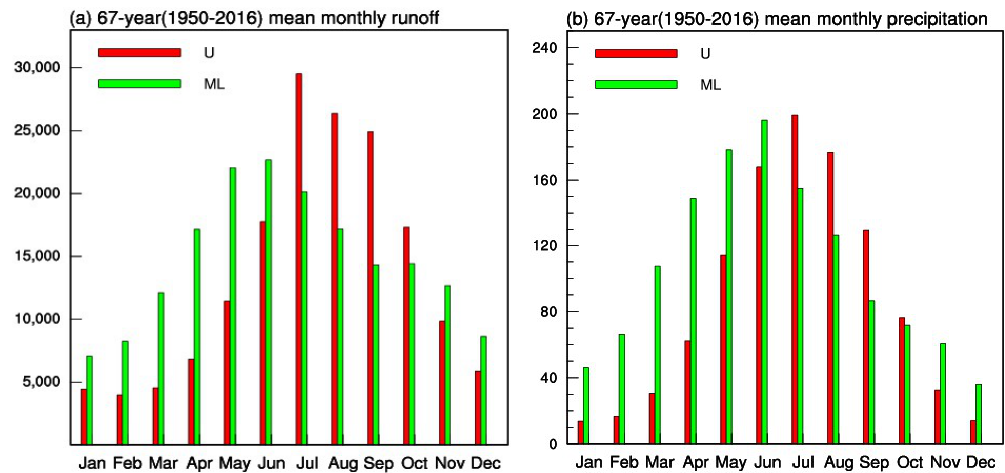
Figure 2. Distribution of observed multiyear average monthly ( a ) runoff (m 3 /s) and ( b ) precipitation (mm/day) from 1950 to 2016. The red and green bars represent the upper and mid-lower reaches of the YR, respectively.